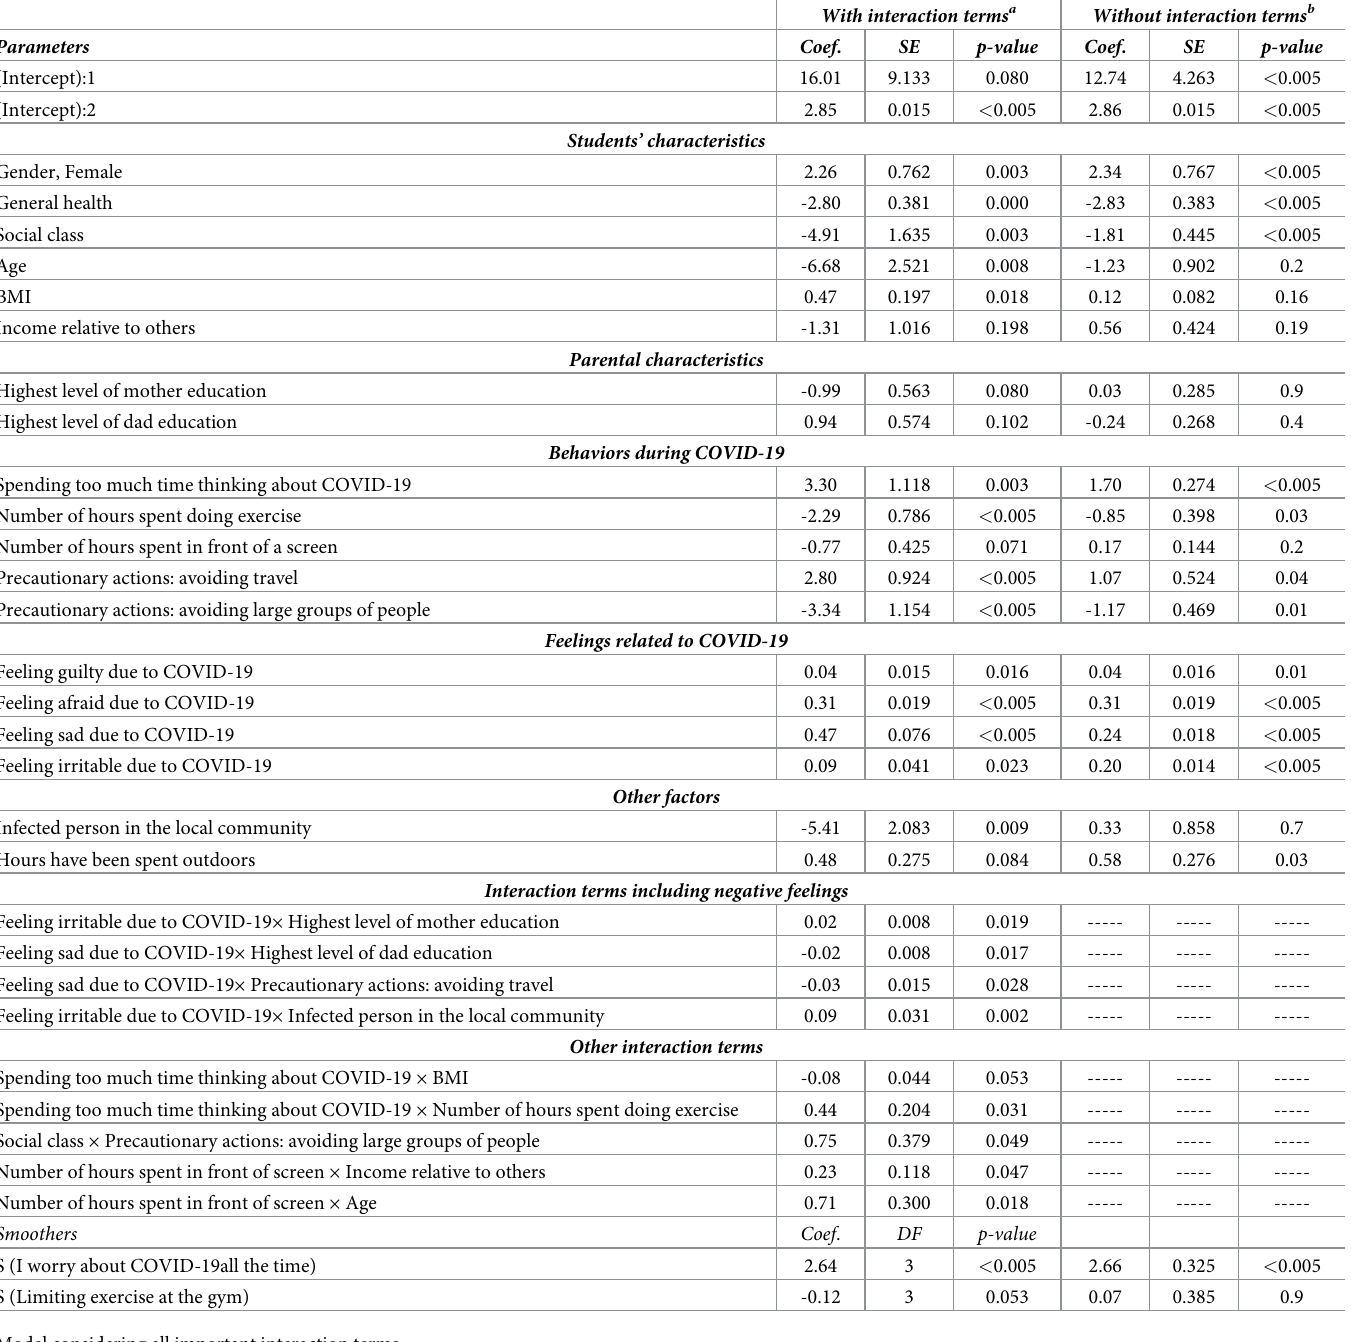
Table 2. Parameters estimates of models with and without interaction